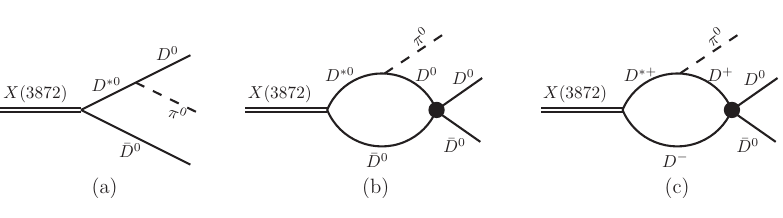
Figure 1. Diagrams contributing to the decay X (3872) → D 0 ¯ D 0 π 0 : (a) Tree level diagram, (b) and (c): final state